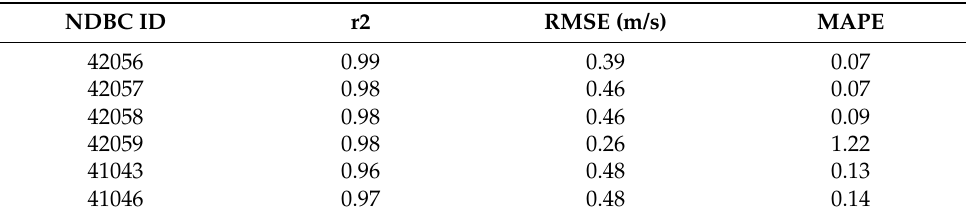
Table 4. Error statistics between LSTM-generated synthetic surface wind speeds and NDBC